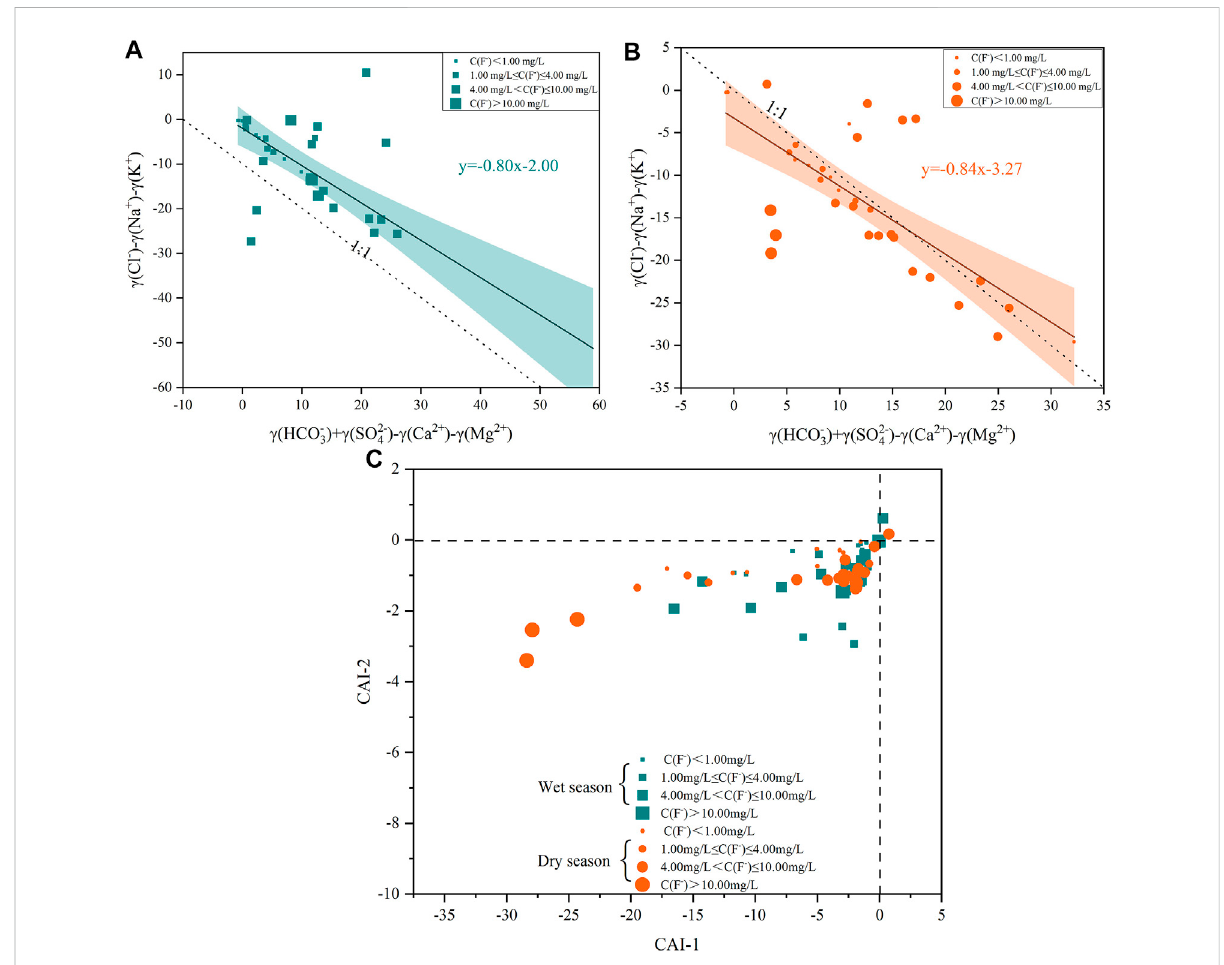
FIGURE 6 The plots of: (A) Cl - -Na + -K + versus HCO 3 − +SO 4 2 − -Ca 2+ -Mg 2+ during the wet season; (B) Cl - -Na + -K + versus HCO 3 − +SO 4 2 − -Ca 2+ -Mg 2+ during the dry season; (C) CAI-1 versus CAI-2 during the wet and dry season in deep